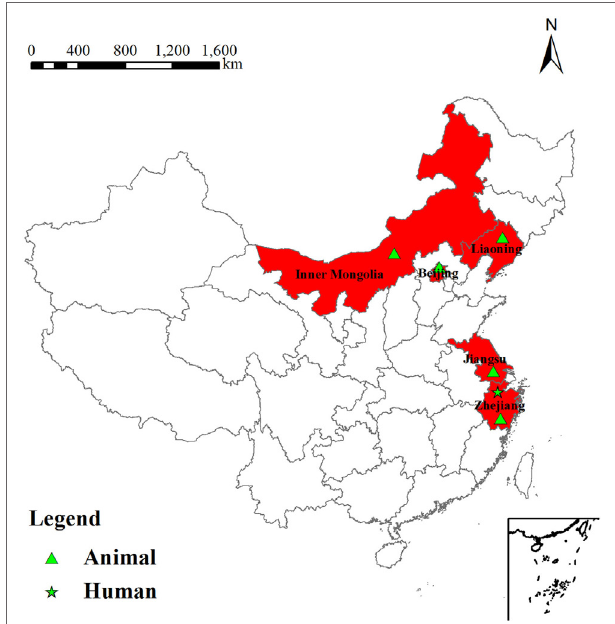
FigUre 1 | Location of Brucella canis isolated from human and animals between 2006 and